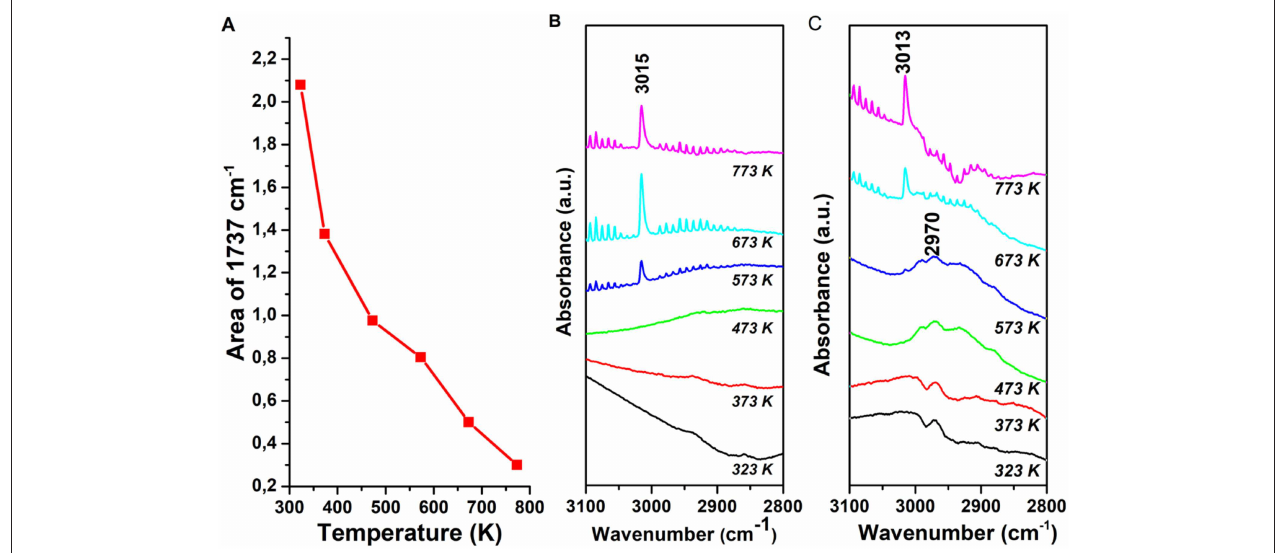
FIGURE 9 | Peak area of the 1,737 cm − 1 peak region as a function of temperature (A) , DRIFTS spectra of H-ZSM-5-30 in CH region (B) , DRIFTS spectra of Pt-H-ZSM-5-30 in CH region during reaction condition (C)